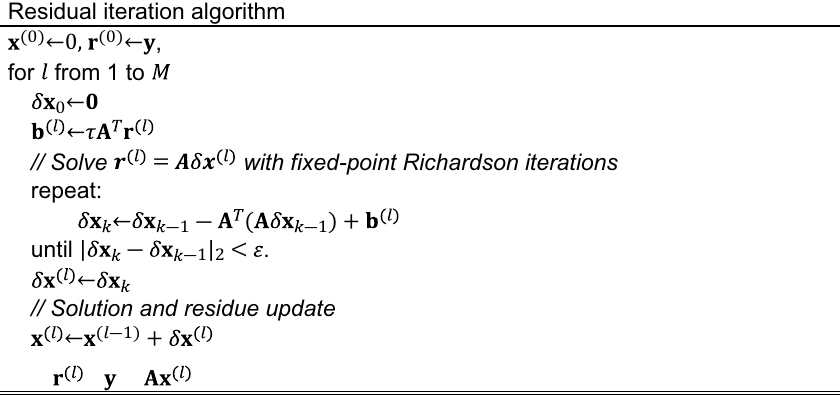
Algorithm I. Fixed-point residual iteration for solving the linear system